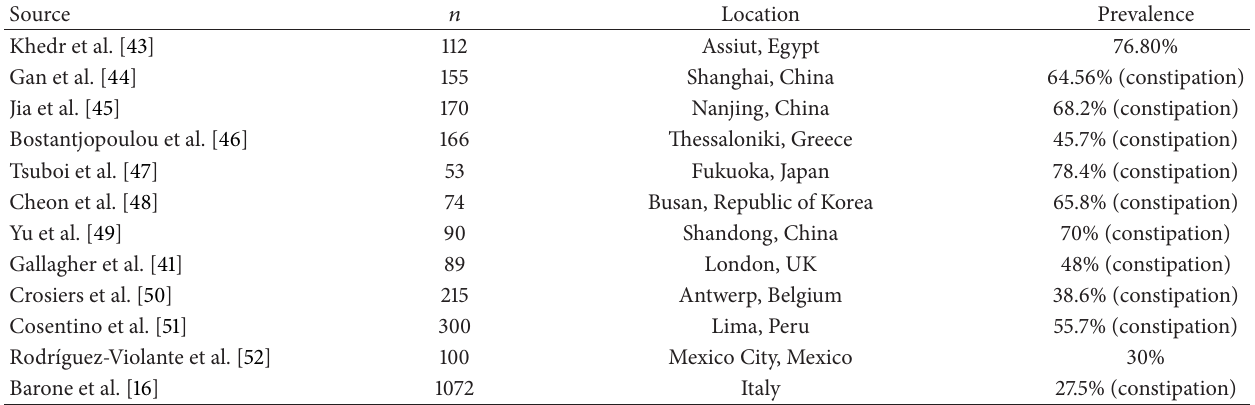
Table 5: Prevalence rate of gastrointestinal symptoms in studies using